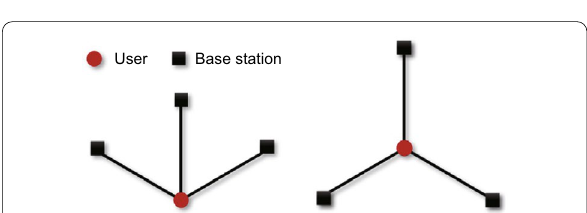
Fig. 1 Optimal distribution of three base stations